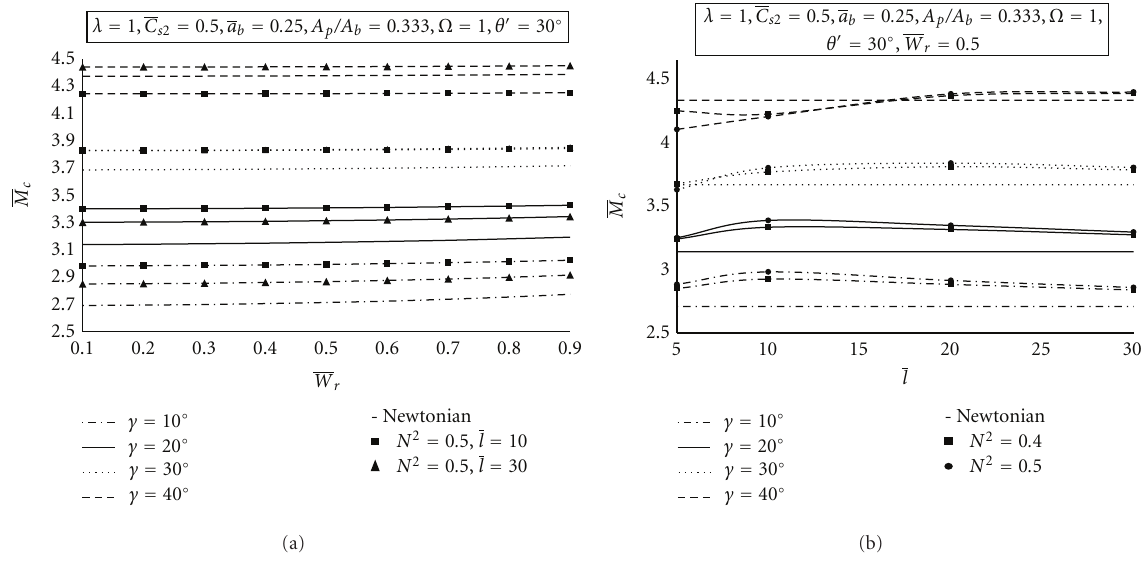
Figure 11: (a) Variation of M c versus radial load W r . (b) Variation of M c versus characteristic length l .